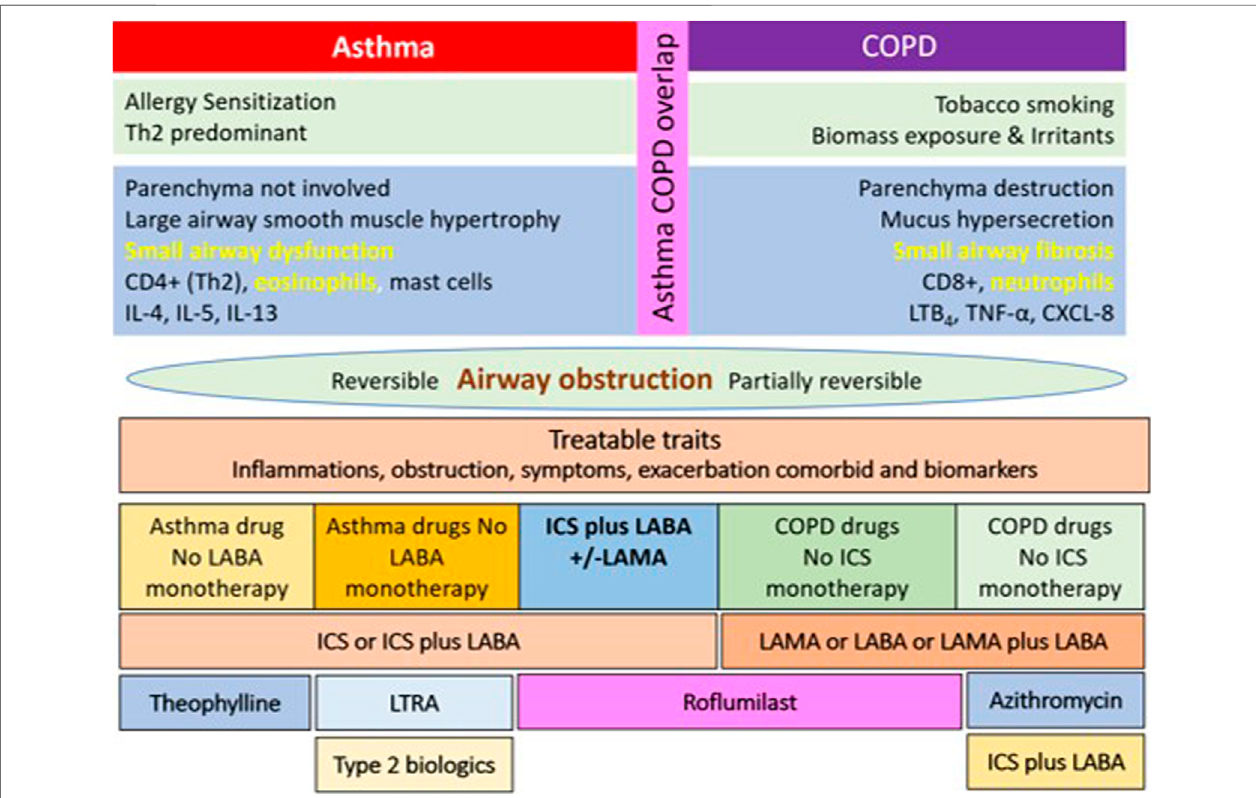
FIGURE 2 | The diagram of the possible role and position of ro fl umilast for being asthmatic controller in a stepwise approach to asthma pharmacologic treatment. ICS: inhaled corticosteroid; SMI: soft mist inhaler; OCS: oral corticosteroid.